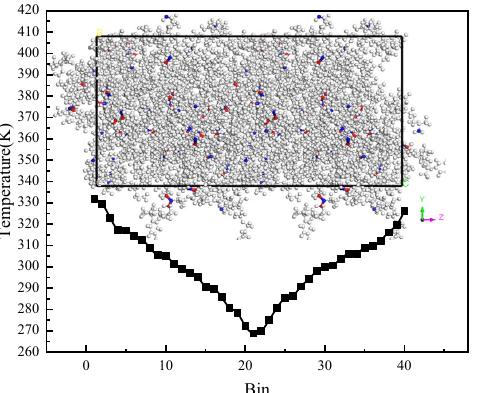
Figure 12. Temperature distribution along the z direction with degree of cross-linking of 85.4%.